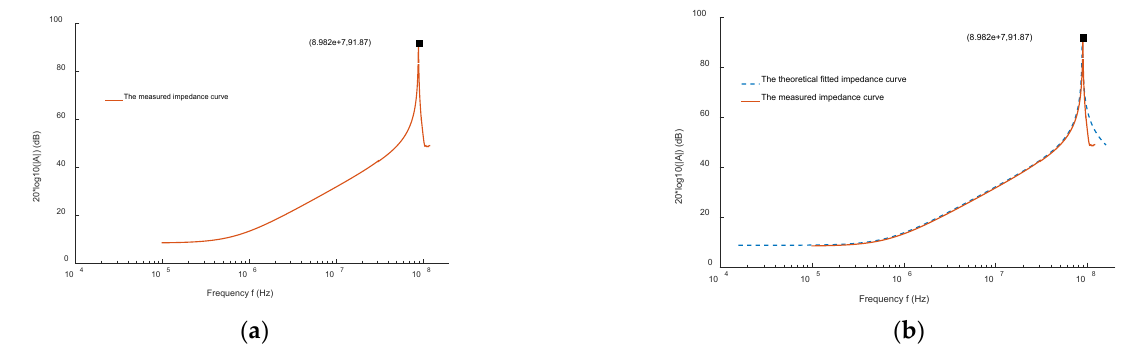
Figure 15. Impedance sweep curve. ( a ) Measured impedance sweep curve, ( b ) theoretical correction and measured anti-sweep curve.